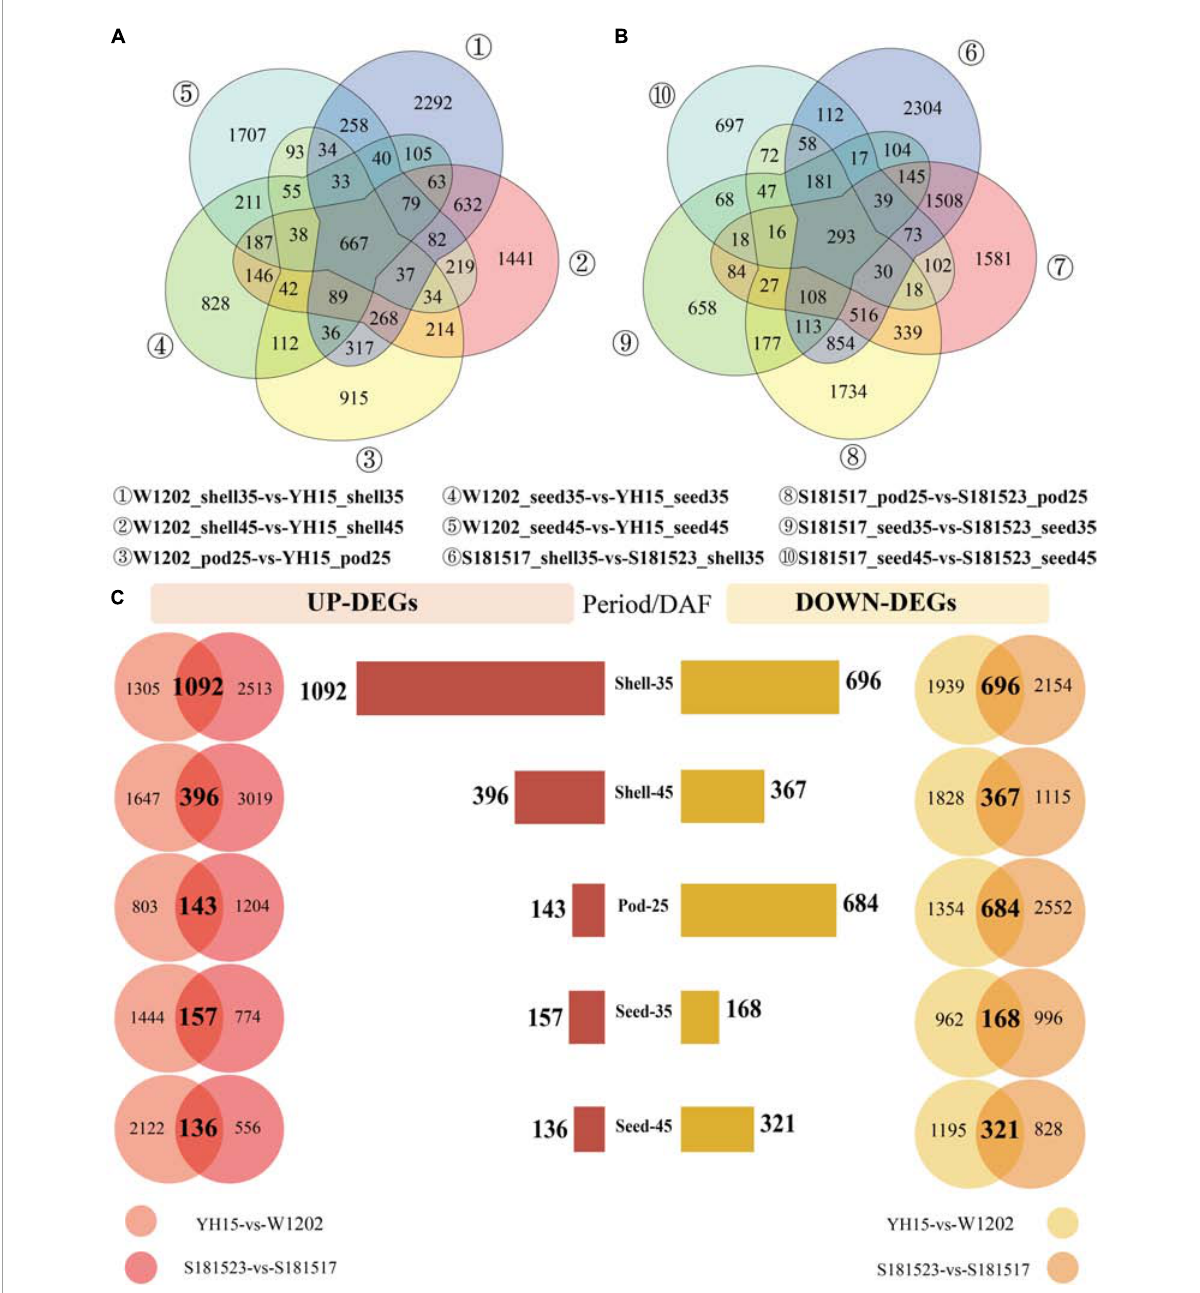
FIGURE3 Analysis of differentially expressed genes (DEGs) in the comparisons of YH15 vs. W1202 and S181523 vs. S181527. (| log2 fold-change| > 1, corrected p -value < 0.05). (A) The number of DEGs between YH15 and W1202 at each pod developmental stage. (B) The number of DEGs between S181523 and S181527 at each pod developmental stage. (C) The number of intersected DEG s in five phases: Shell-35, Shell-45, Pod-25, Seed-35, and Seed-45